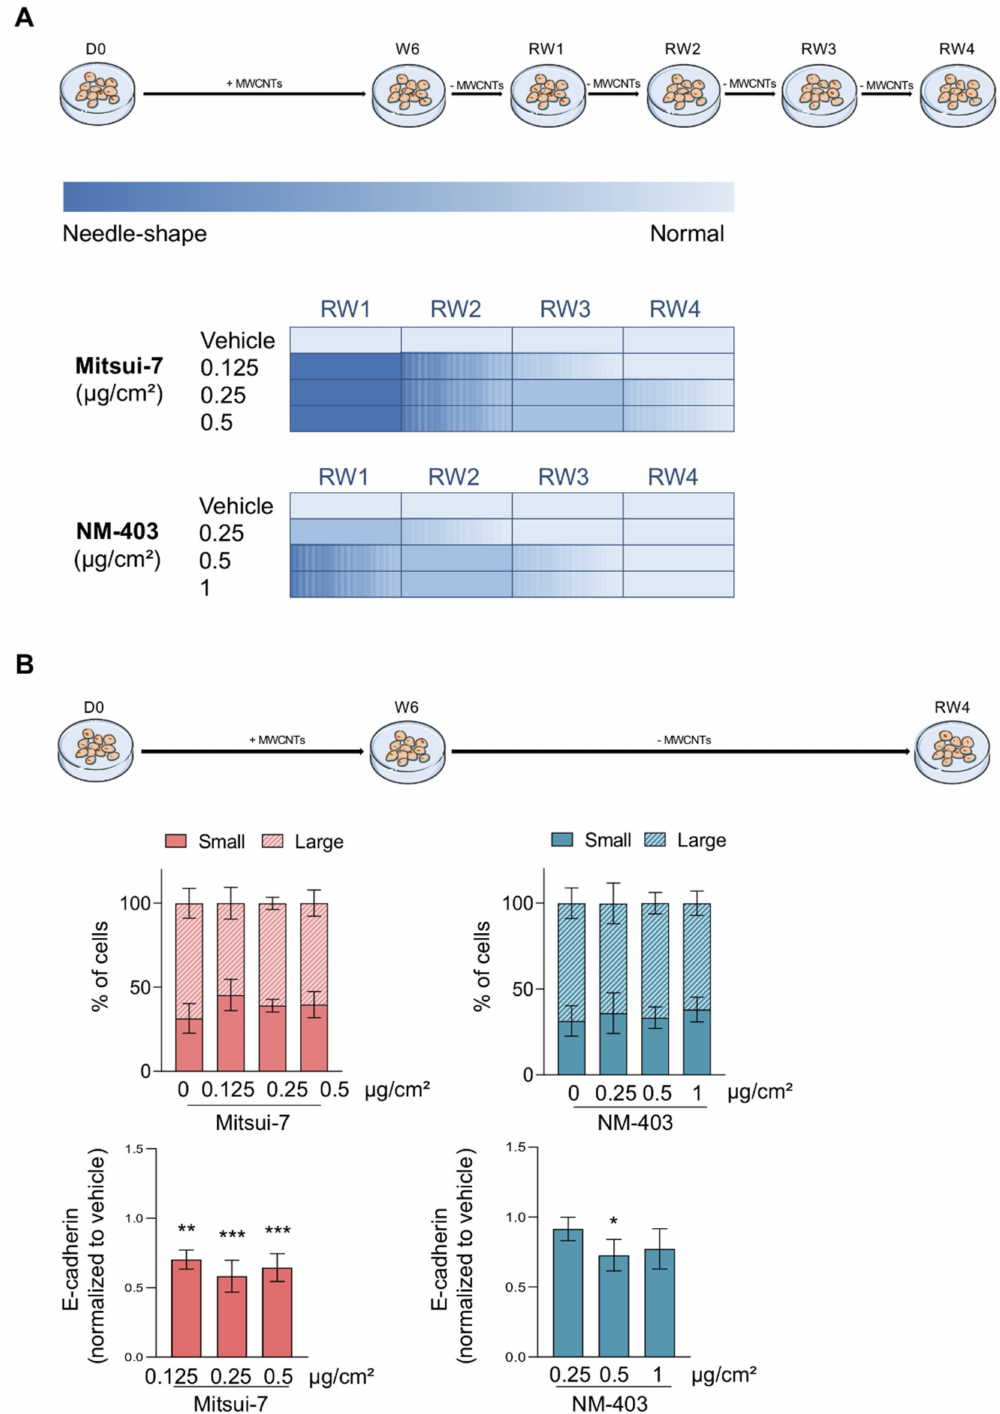
Figure 9. The MWCNTs-induced EMT is reversible. After the 6 weeks of treatment with Mitsui-7 (0.125, 0.25 and 0.5 µ g/cm 2 ) or NM-403 (0.25, 0.5 and 1 µ g/cm 2 ), the cells were cultured without treatment for 4 weeks (RW1-RW4). ( A ) The heatmap represents the morphological changes observed in cells during the 4 weeks of the recovery period from needle shape (dark blue) to normal shape (light blue). ( B ) The two cellular populations (small and large cells) were analysed using flow cytometry and determined based on SSC:FSC profiles during the RW4. The extracellular marker E-cadherin was quantified in the population of small cells using flow cytometry and the bar graph represents the ratio of mean fluorescence intensity/total number of cells reported to the vehicle. The histograms represent the mean ± standard error of the mean (SEM) for three independent experiments. * p < 0.05, ** p < 0.01, *** p < 0.001 significantly different from the